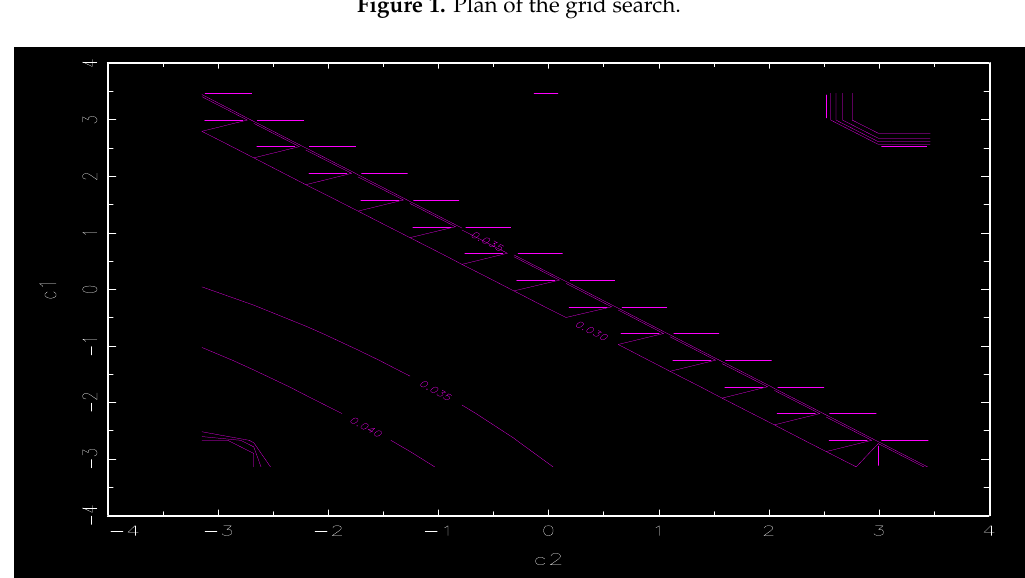
Figure 2. Contour map of grid search.